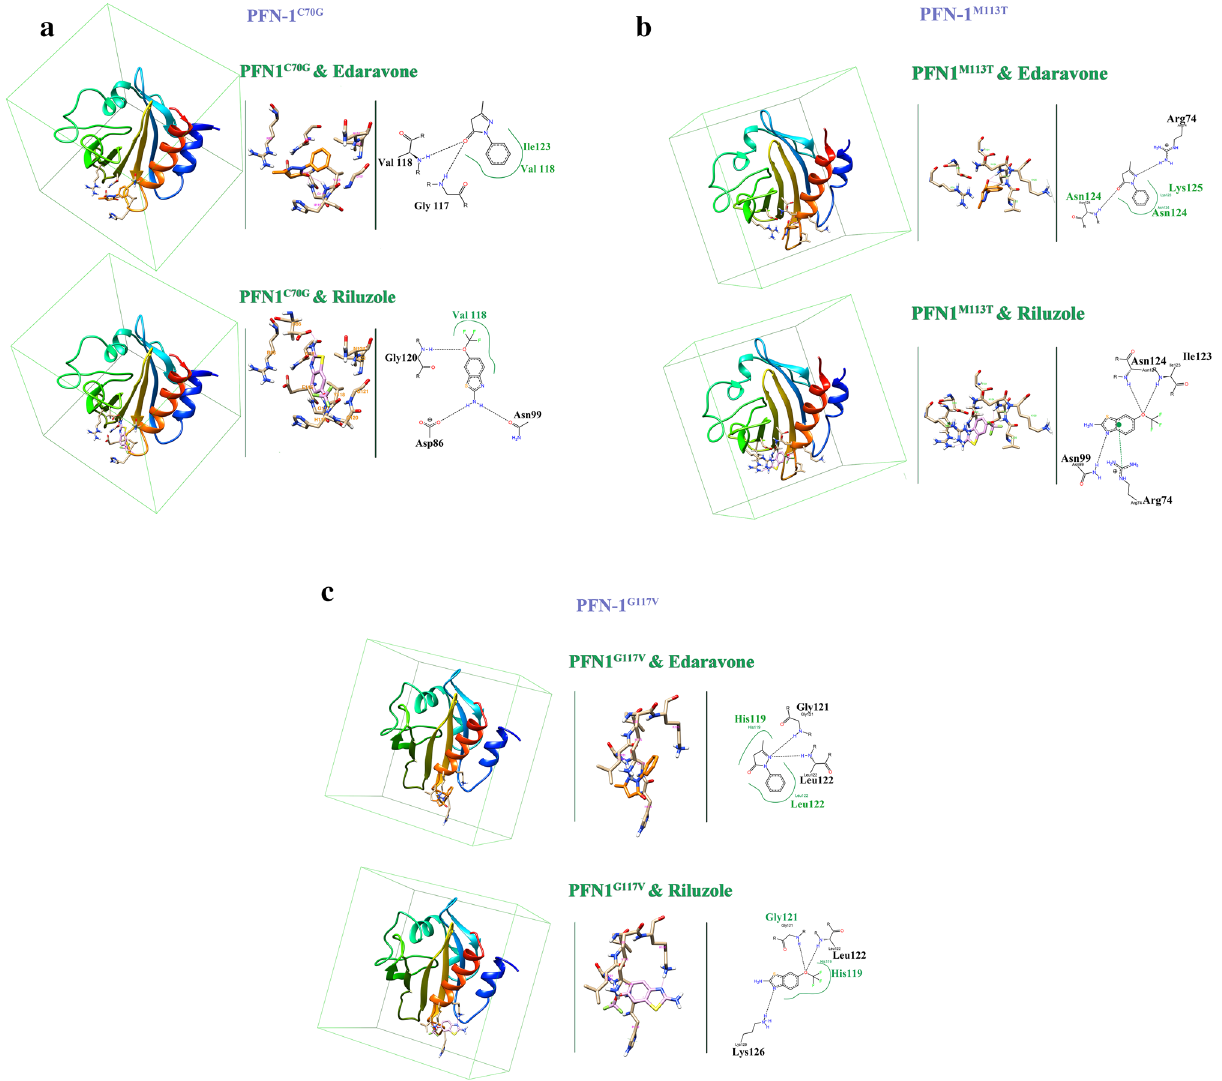
sticks, and molecular view. ( a ) Riluzole and Edaravone interacting with C70G mutant PFN-1 ( b ). Riluzole and Edaravone interacting with M113T mutant PFN-1. ( c ) Riluzole and Edaravone interacting with G117V mutant